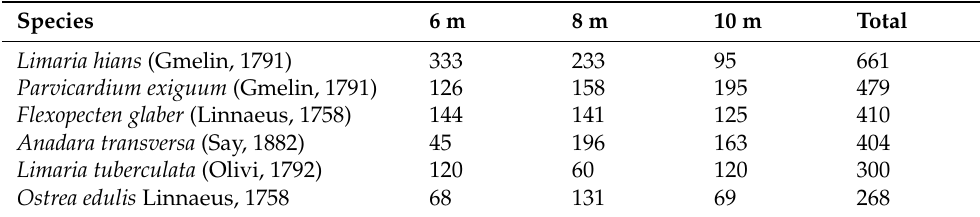
Table 1. The most abundant bivalve species on larval collectors in Javorike Cove in